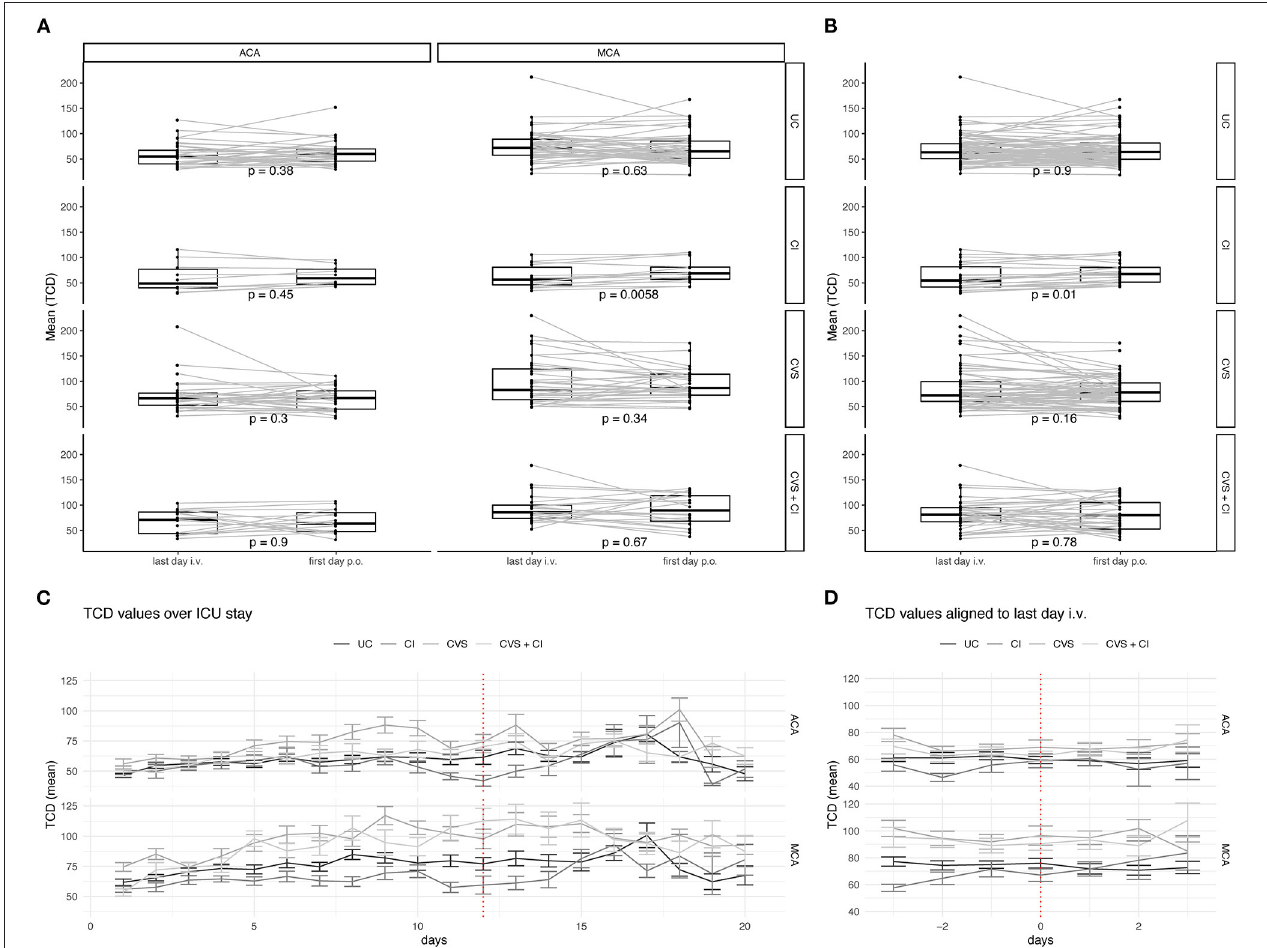
FIGURE 2 | Analysis of TCD-values of subgroups during the switch of the route of administration. TCD values are measured longitudinal in all patients during the ICU stay. Grouping is done according to radiological findings: Uncomplicated Course (UC), Cerebral Infarction (CI), Cerebral Vasospasms (CVS), and Cerebral Vasospasm and Cerebral Infarctions (CVS + CI). (A) Only patients with consecutive values before and after switching the route of administration of nimodipine are depicted. Values for A. cerebri anterior (left) and A. cerebri media (right) are depicted separately. (B) All TCD values independent of their circulation are depicted. The lower and upper hinges of the boxplots correspond to the first and third quartile of all values. The whiskers represent the 1.5 inter quantile range (IQR). Dots show each value and grey lines connect individual patients’ measurements. Statistical analysis was performed with paired t -test. (C) Mean TCD values are shown over the first 20 days of ICU stay for A. cerebri anterior (upper) and A. cerebri media (lower). Error bars represent the standard deviation. (D) Mean TCD values aligned to the individual switch of the route of administration. Whiskers represent. Error bars represent the standard deviation.